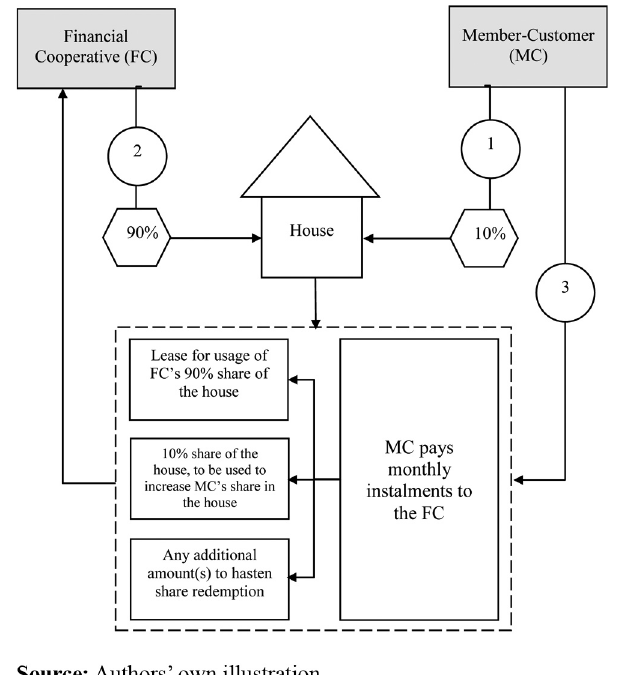
Figure 1. MM home fi nancing